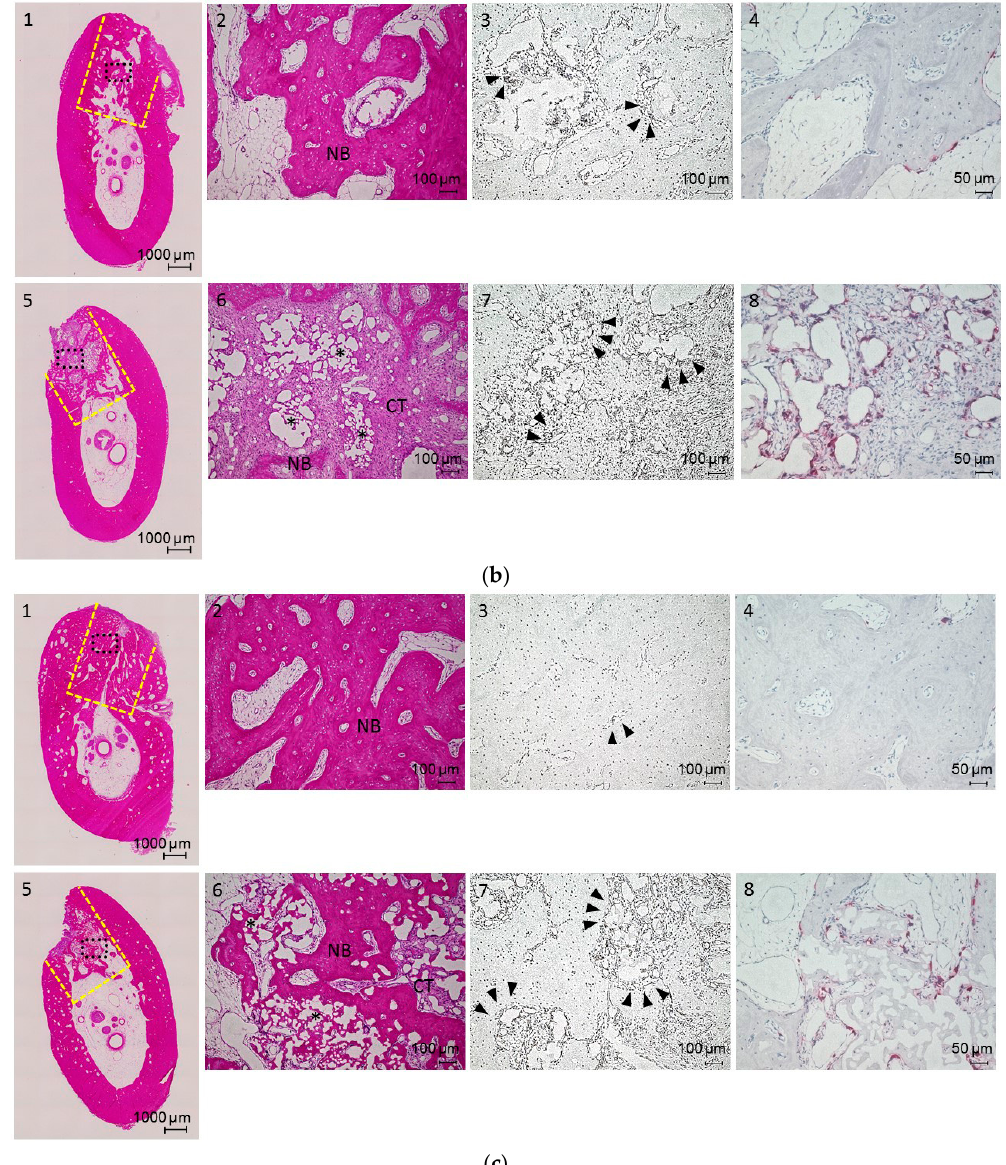
Figure 5. ( a ) Hematoxylin and eosin (H&E)-stained sections ( 1 , 2 , 5 and 6 ), immunostaining ( 3 and 7 ), and tartrate-resistant acid phosphatase (TRAP) staining ( 4 and 8 ) of bone defects in the bFGF ( 1 – 4 ) and control ( 5 – 8 ) groups at two weeks; ( b ) H&E-stained sections ( 1 , 2 , 5 and 6 ), immunostaining ( 3 and 7 ), and TRAP staining ( 4 and 8 ) of bone defects in the bFGF ( 1 – 4 ) and control ( 5 – 8 ) groups at four weeks; and ( c ) H&E-stained sections ( 1 , 2 , 5 and 6 ), immunostaining ( 3 and 7 ), and TRAP staining ( 4 and 8 ) of bone defects in the bFGF ( 1 – 4 ) and control ( 5 – 8 ) groups at eight weeks. CT, connective tissue; NB, newly formed bone; black triangles, new vessels labeled for von Willebrand Factor (vWF); * residual granule. Yellow dotted lines, defect area; black dotted lines, higher magnification area. At four weeks, most of the α -TCP particles in the bFGF group were degraded and replaced with new bone (Figure 5b-1 and -2). New vessels were still observed around residual α -TCP particles (Figure 5b-3 and -4). Few osteoclasts were observed by TRAP staining (Figure 5b-4). In the control group, α -TCP particles were surrounded by connective tissue (Figure 5b-6), which harbored many